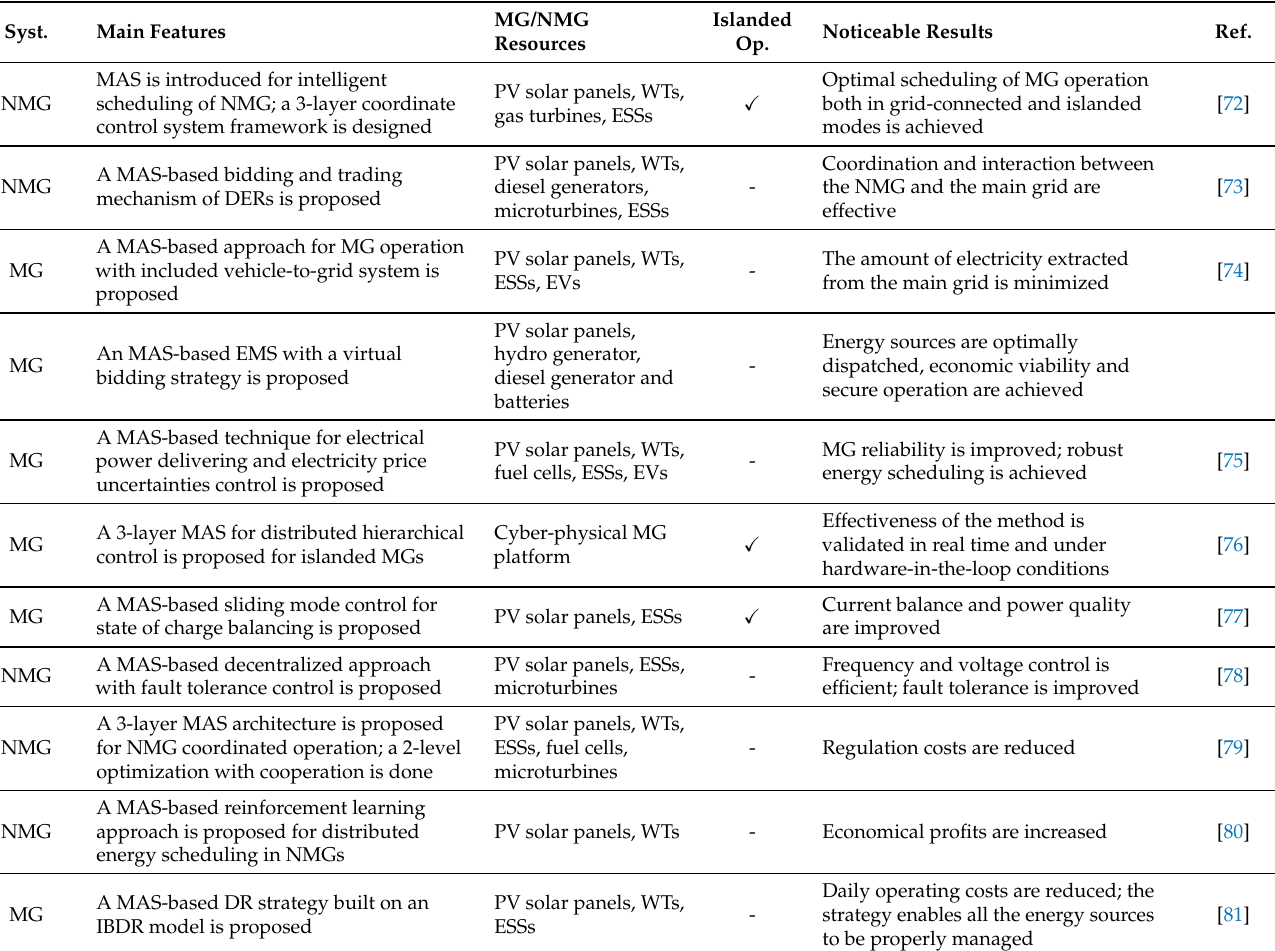
Table 4. A focus on papers dealing with multi-agent systems (MASs) for MG/NMG management. DER stands for distributed energy resource. DR stands for demand response. ESS stands for energy storage system. IBDR stands for incentive-based demand response. MG stands for microgrid. NMG stands for networked microgrid. WT stands for wind